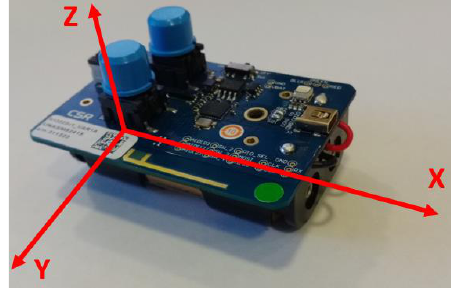
Figure 10. X, Y and Z plans in a CSR1010 device.